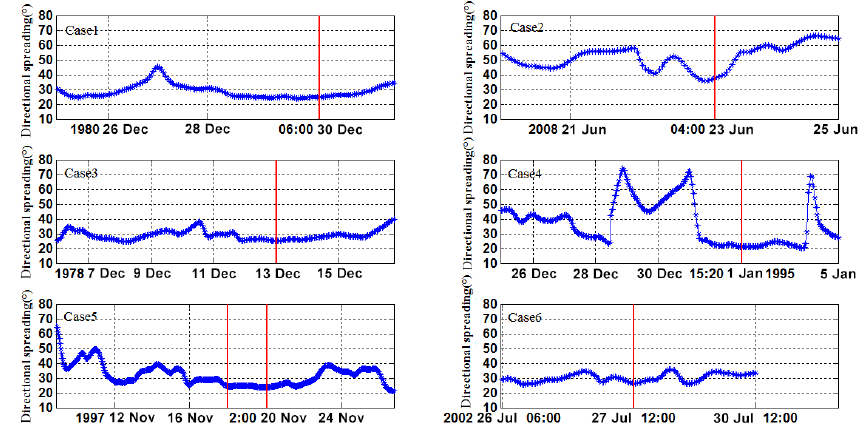
Figure 5. Time series of simulated directional spreading (cases 1–6), red lines refer to the freak waves occurrence time.